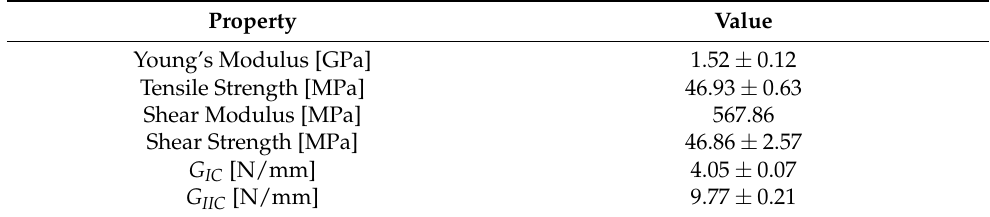
Table 1. 3M AF 163-2k mechanical properties [24,46].